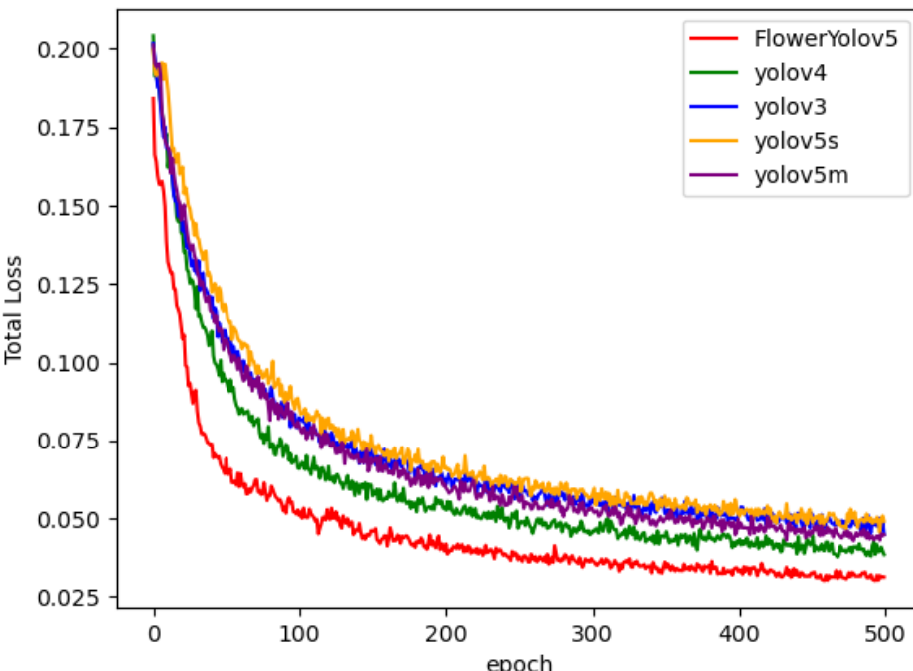
Figure 8. Total loss curves of the five object detection models.